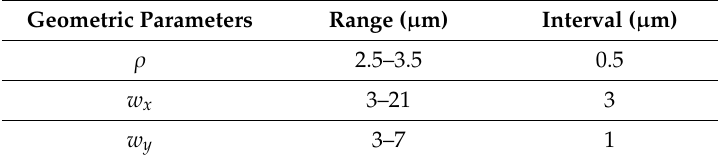
Figure 3. Normalized infrared absorption efficiencies (IAEs) ( a ) and normalized output voltages ( b ) normalized by the individual maximum with the target temperature for the thermopiles with MA-SRHAs and without structure, where the solid lines with triangle and square respectively represent the cases of w y = 3 μm and w y = 3.5 μm, and the dashed lines with round represents w/o structure case. Table 1. Range and interval of geometric parameters selected during simulation .